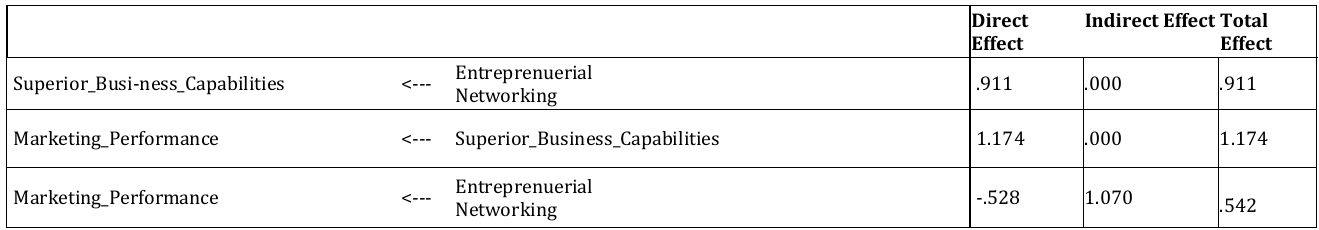
Table 5 : The Contribution Of Direct And Indirect